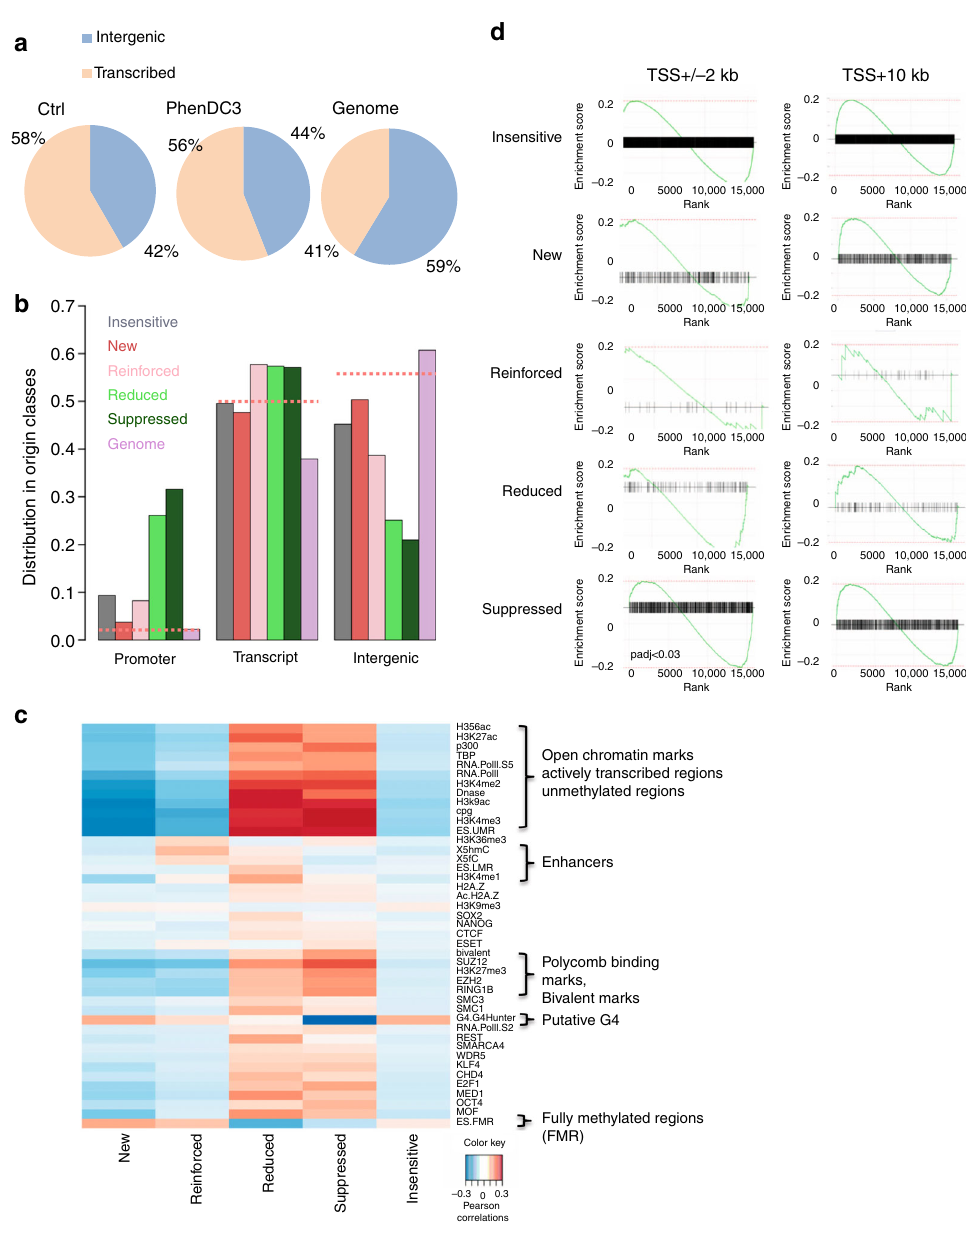
Fig. 5 Transcription and epigenetic landscape in the different origin classes. a Venn diagrams showing the origin distribution between transcribed and intergenic regions in Control and PhenDC3-treated mES cells, and random distribution (Genome). Replication initiation sites are enriched in gene regions. b Genomic localization of the different classes of origins relative to transcription. Downregulated origins (suppressed and reduced) are mainly located at promoters. Random origins (dotted lines) are equally distributed in transcription-related regions. c Epigenetic marks associated with the different origin classes. All tested open chromatin marks were enriched around reduced and suppressed origins. New and reinforced origins were located mainly in highly methylated regions. d GSEA analysis of origins situated at promoters (TSS ± 2 kb, left panels) or in transcribed regions (TSS + 10 kb, right panels) for each class. A plot is drawn for each gene set. The x -axis of each plot represents differentially expressed genes ranked from upregulated (on the left) to downregulated (on the right). The enrichment score is indicated on the y -axis. The black horizontal bar indicates the genes present in the gene set. The highest enrichment score indicates the enrichment. If this score is on the left, the enrichment is higher for upregulated genes; if it is on the right, the enrichment is higher for the downregulated genes. Origins associated with the TSS follow the transcription changes upon G4 stabilization, whereas origins located in transcribed regions are insensitive to changes in transcription levels. At gene promoters, GSEA results show a signi fi cant association of downregulated genes with the suppressed origin class (after multi-testing correction using the Benjamini – Hochberg method, adjusted p < 0.03). The